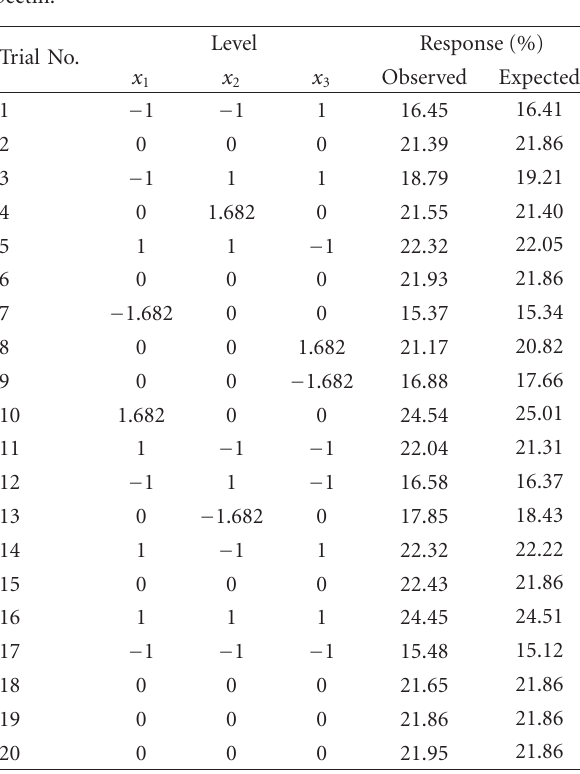
Table 2: Experimental designs and the response for the yield of pectin.